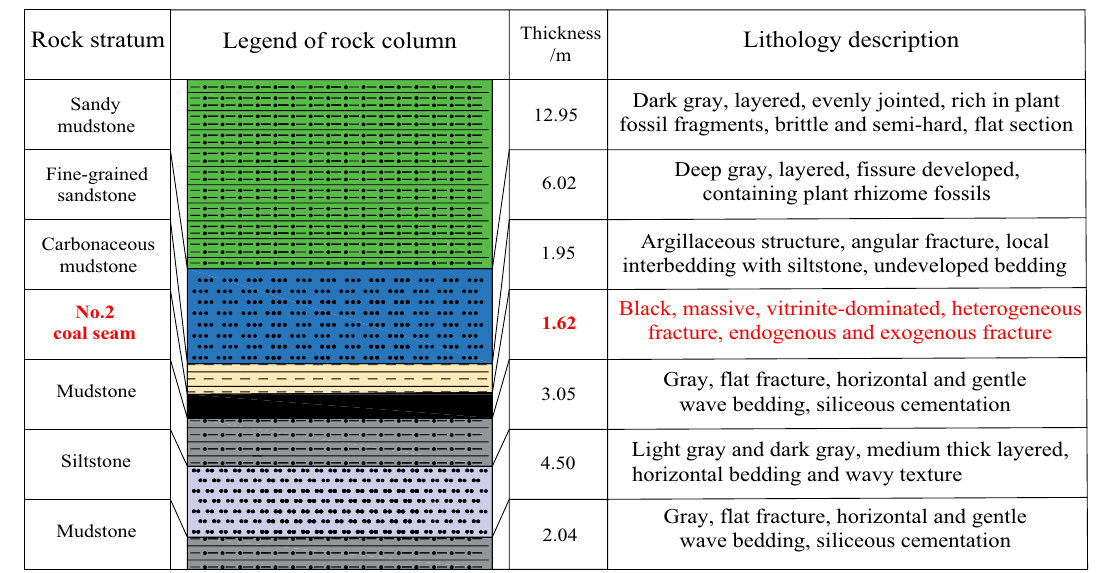
Deep gray, layered, fissure developed, containing plant rhizome fossils Argillaceous structure, angular fracture, local interbedding with siltstone, undeveloped bedding Black, massive, vitrinite-dominated, heterogeneous fracture, endogenous and exogenous fracture Gray, flat fracture, horizontal and gentle wave bedding, siliceous cementation gray and dark gray, medium thick layered, horizontal bedding and wavy texture Gray, flat fracture, horizontal and gentle wave bedding, siliceous